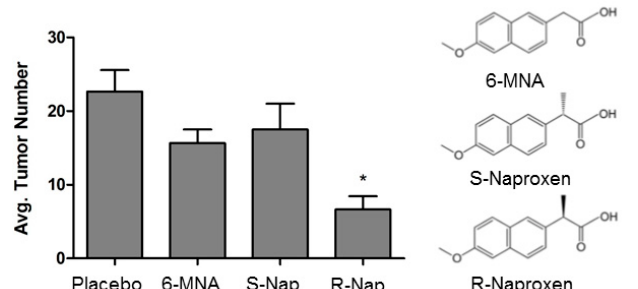
Figure 1. R-Naproxen reduces ovarian tumor peritoneal implants in a xenograft model. One day prior to intraperitoneal injection of green fluorescent protein (GFP)-tagged SKOV3ip cells into athymic nude mice, mice were administered placebo or the indicated treatments to approximate serum levels equivalent to human dosing. Drug was administered daily for 2 weeks. At this time, mice were sacrificed, and images of the peritoneal cavity were obtained. All tumors were counted and aided by GFP imaging. * p < − 0.05 C = placebo; 6-MNA = 6-methoxy-2-naphthylacetic acid; S-Nap = S-naproxen; R-Nap = R-naproxen. 6-MNA is the active metabolite of the non-racemic NSAID nabumetone and is structurally similar to R-naproxen but lacks the alpha-methyl carboxylate ( α -Me-COOH) determined to be essential for activity [63].